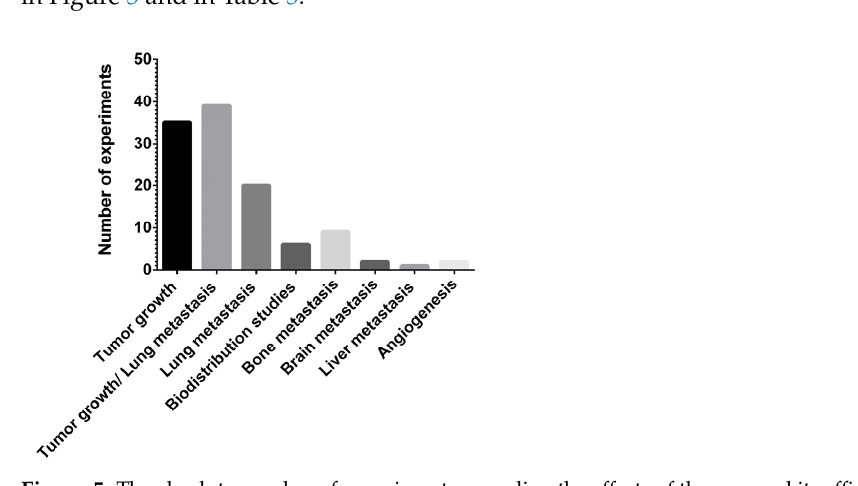
Figure 5. The absolute number of experiments regarding the effects of therapy and its efficacy are